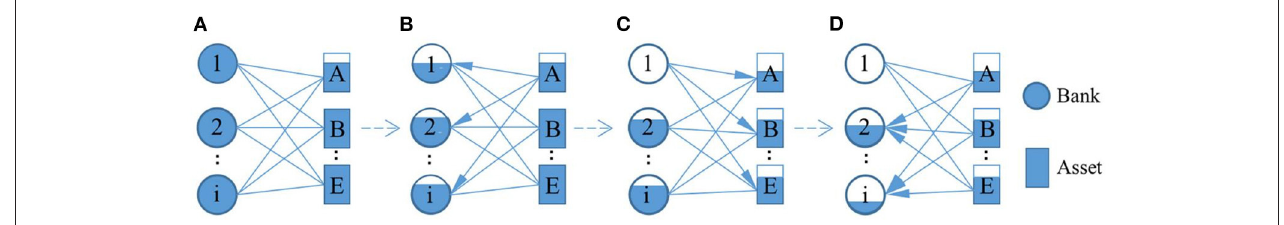
FIGURE 1 | Evolution of bank-asset bilateral network. (A) Represents the asset class A depreciates. (B) Represents the total value of bank 1, bank 2 ... bank i that invest in asset class A suffers losses. (C) Represents bank 1 defaults, the assets it held asset A, asset B ... asset E depreciates. (D) Represents the total value of bank 2 ... bank i suffers